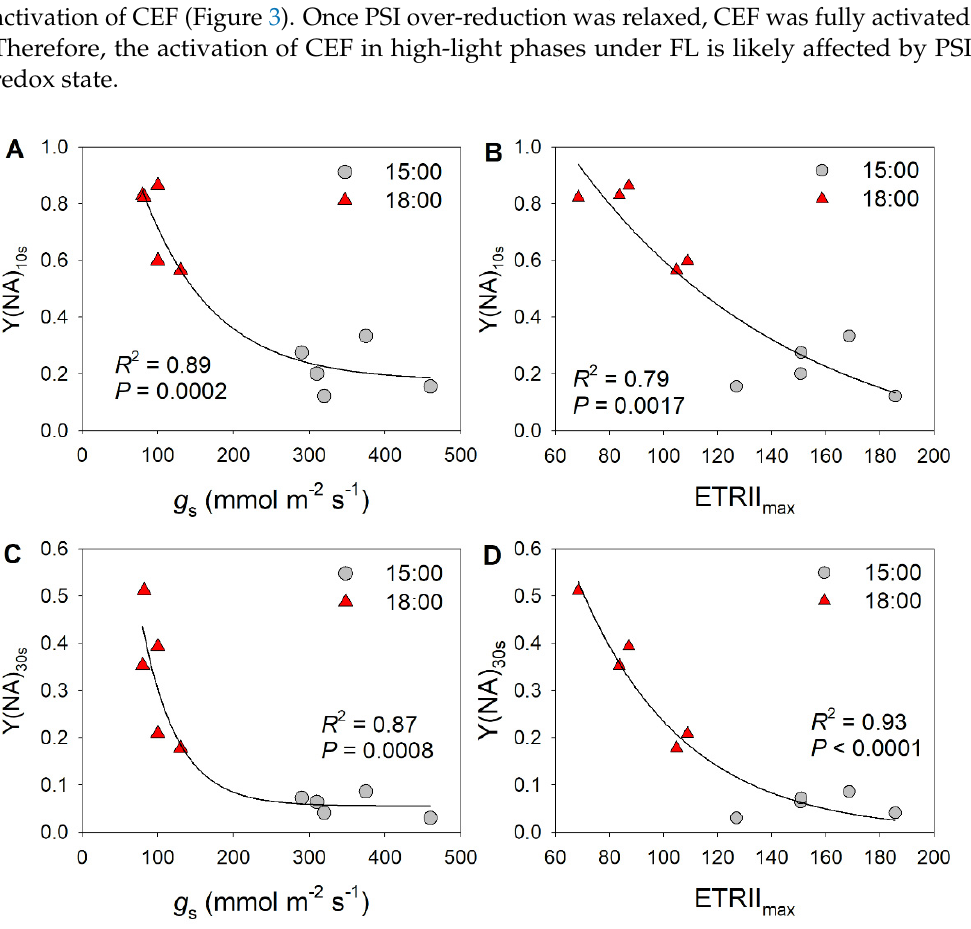
5 of 13 Figure 1. Assessment of diurnal photosynthetic performance in tomato leaves measured at 15:00 and 18:00: ( A ) stomatal